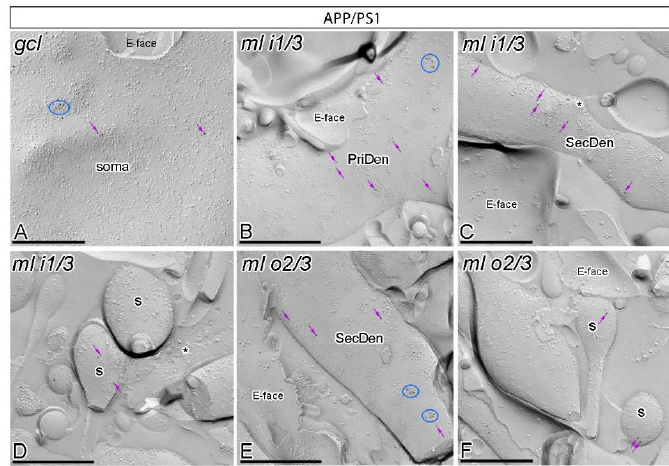
Figure 3. Subcellular localisation of GABA B1 in somato-dendritic domains of granule cells in APP/PS1 mice. ( A – F ) Electron micrographs obtained from different parts of the DG showing immunoparticles for GABA B1 along the surface of granule cells, as detected using the SDS-FRL technique in APP/PS1 mice at 12 months of age. Immunoparticles for GABA B1 were detected at lower frequency forming clusters (blue ellipses/circles) or scattered (purple arrows) associated with the P-face in the soma, primary dendrites (PriDen), secondary dendrites (SecDen) and dendritic spines (s) of both the outer two thirds (ml o2/3) and inner one third (ml i1/3) of the molecular layer. Fractured spine necks are indicated with asterisks (*). The E-face is free of any immunolabelling. Scale bars: A – F , 0.2 μm.